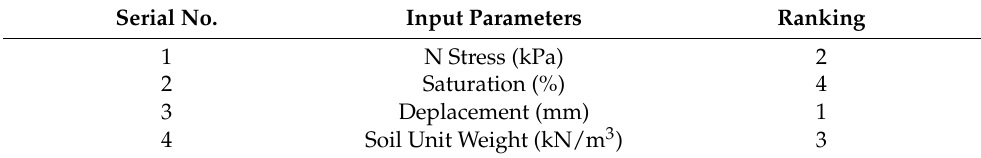
Table 5. Sensitivity analysis of input parameters using Garson’s algorithm. Serial No. Input